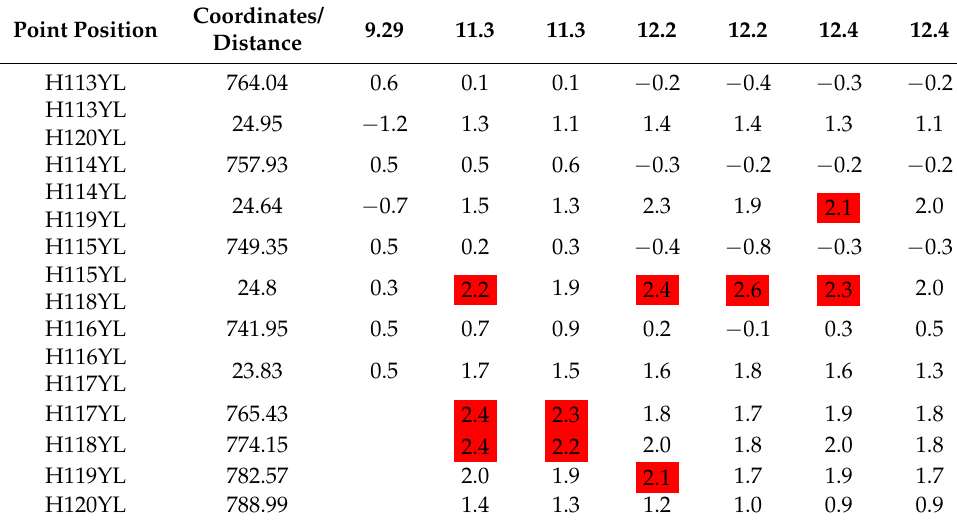
Figure 14. Point measurements of vehicle left front door. Table 3. Window point measurement. (The default unit is mm. The date of data measurement is September 29, November 3, December 2 and December 4. More than 2 mm is marked with red background. The datum plane of the coordinate is the horizontal ground. The data in the table present the difference between the measured value and the reference